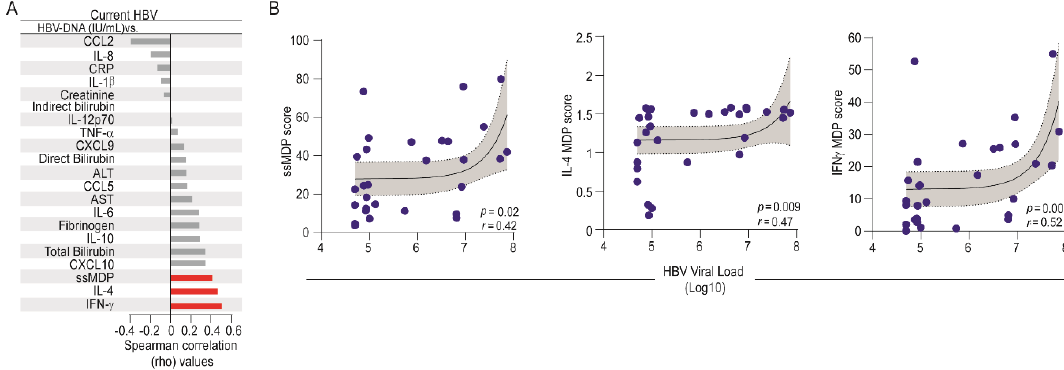
Figure 5. Associations between HBV-DNA viral loads and molecular degree of inflammatory perturbation. Spearman correlation analysis was employed to assess the correlations between the MDP score of each marker and HBV viral loads in patients with current HBV infection. ( A ) Bars show the rho values. Red bars infer the significant interactions ( p -value < 0.05). ( B ) Lines represent linear adjustment of the curve with 95% confidence intervals for each parameter that was significantly correlated with HBV viral load. Abbreviations (alphabetic order): ALT: alanine aminotransferase; AST: aspartate aminotransferase; CCL: C-C motif chemokine ligand; CXCL: C-X-C motif chemokine ligand; CRP: C-reactive protein; IFN: interferon; IL: interleukin; TNF: tumor necrosis factor.